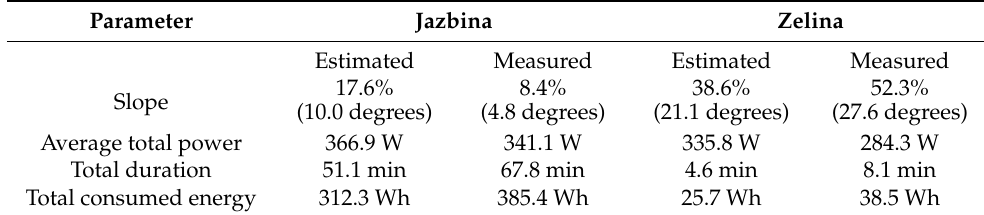
Table 7. Comparison of estimated and measured